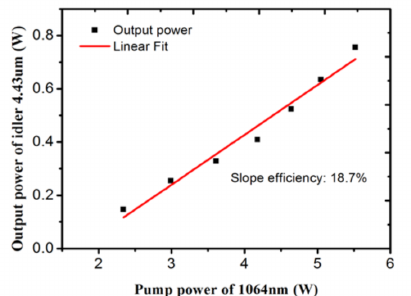
Figure 4. Output power of the idler light versus the input pump power.